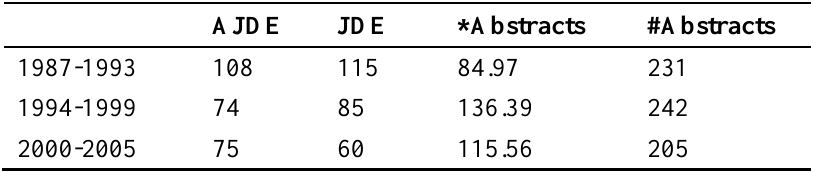
Articles by Journal and Time Period, Average Words per Unit, and Number of Terms Extracted by Unit and